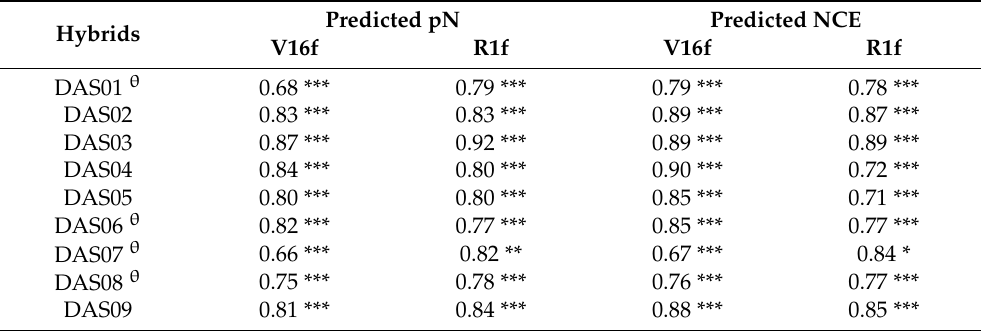
Table 2. Pearson correlation coefficients (r) between measured and predicted values for each PLSR model by